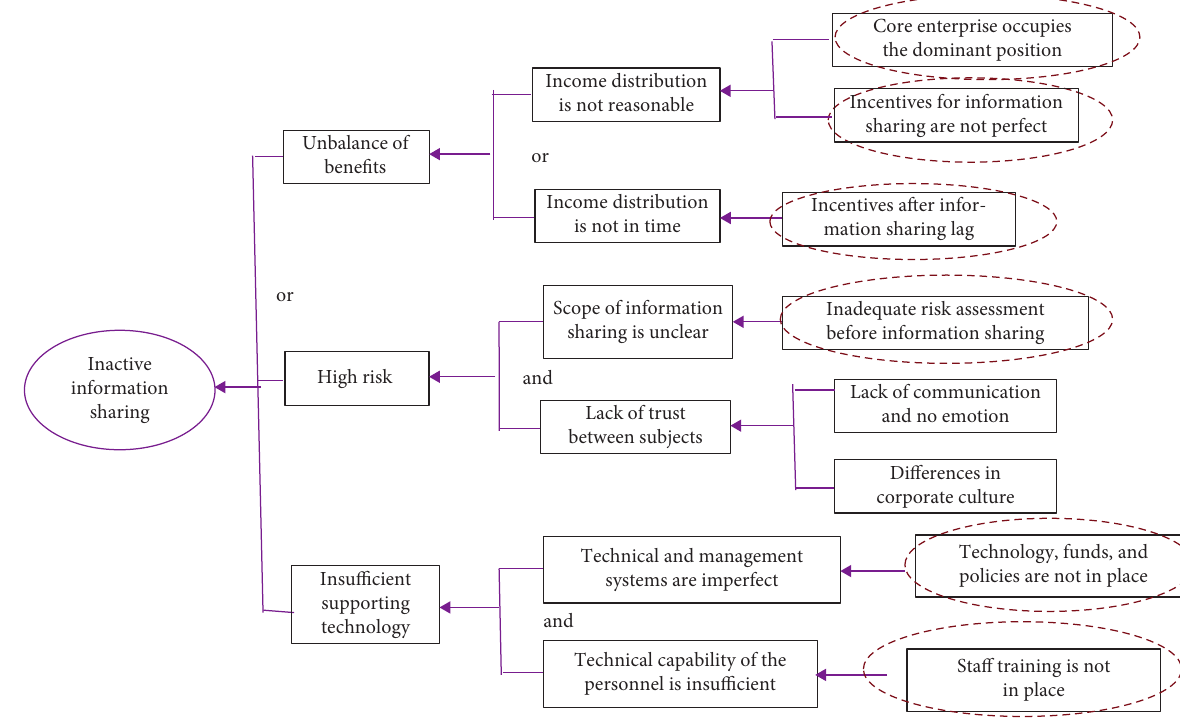
Figure 3: Diagram of causal chain Table 1: List of available resources.